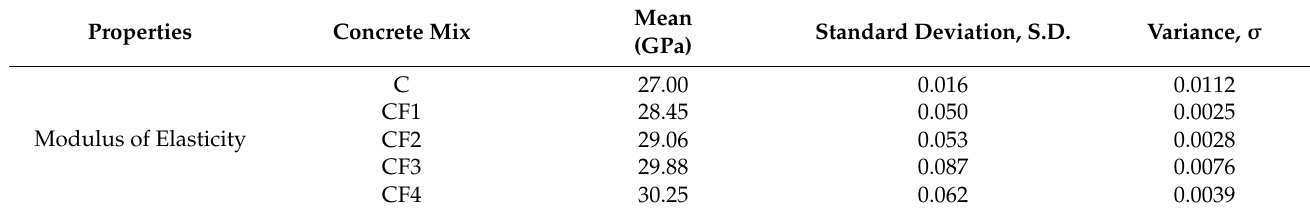
Figure 10. The effect of coir fiber reinforcement on the MOE of concrete. Table 9. Descriptive statistical analysis of concrete subjected to MOE.